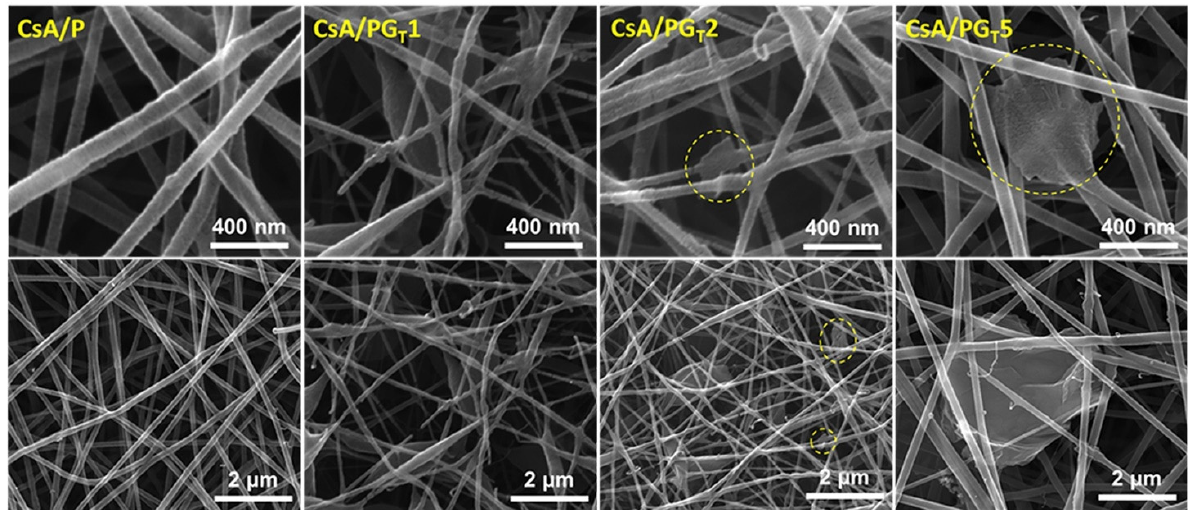
Figure 6. SEM micrographs of CsA/P- and rGO-TEPA-containing CsA electrospun membranes with nanofibrous architecture, at 50,000× and 200,000× magnifications.